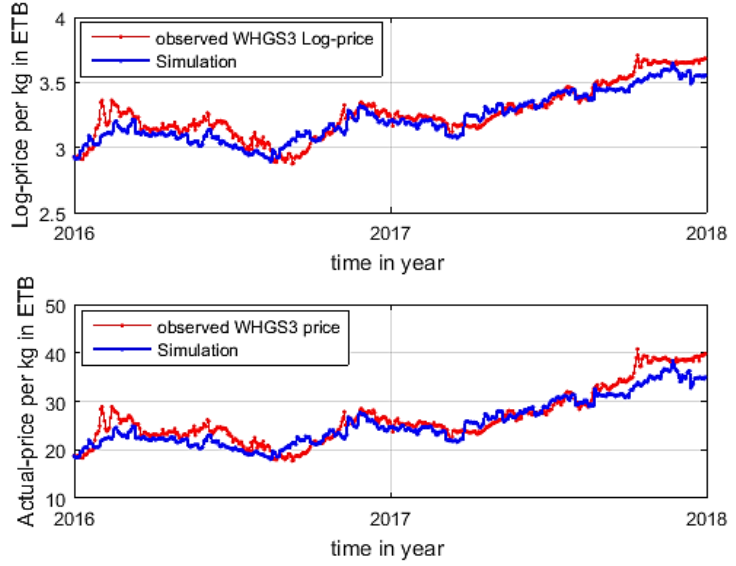
Figure 6. Simulated price fitted to WHGS3 log-price (Upper panel) and WHGS3 price (Lower panel) under DEJD model from 2016 to 2018.